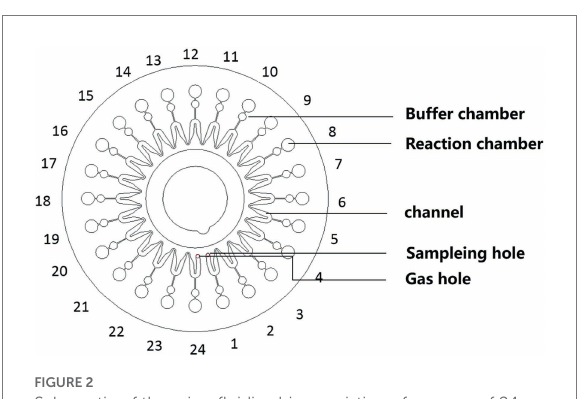
FIGURE 2 Schematic of the microfluidic chip consisting of an array of 24 reaction wells and microchannel for sample inlet, distribution, and